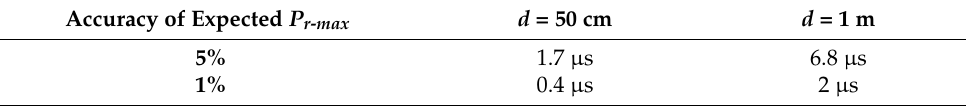
Table 2. Minimal response time required by the sensor to measure P r − max with the required accuracy. Accuracy of Expected P r -